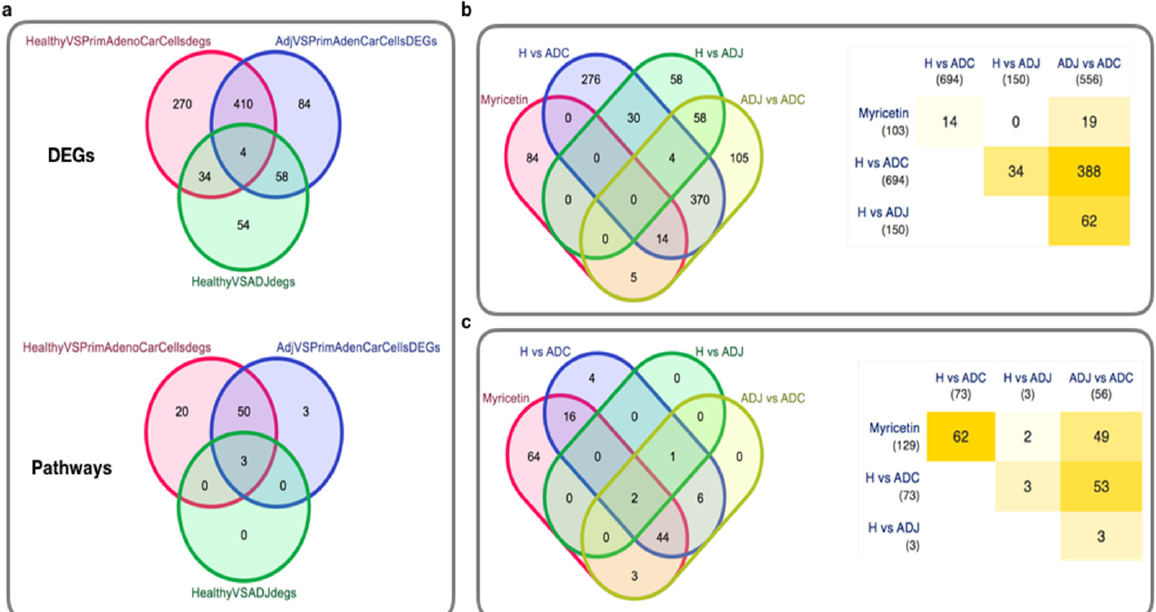
Figure 6. CRC gene expression profiling and pathway enrichment analysis. ( a ) Venn diagram to show the specific and shared DEGs and enriched pathways in the case of CRC with different types of samples. ( b ) Venn diagram to show the specific and shared DEGs and common DEGs with myricetin targets. ( c ) Pathway-level linkage of myricetin and the CRC. The degree of yellow color in ( b ) and ( c ) represents the less (low degree) to higher (higher degree) number of overlapping genes.